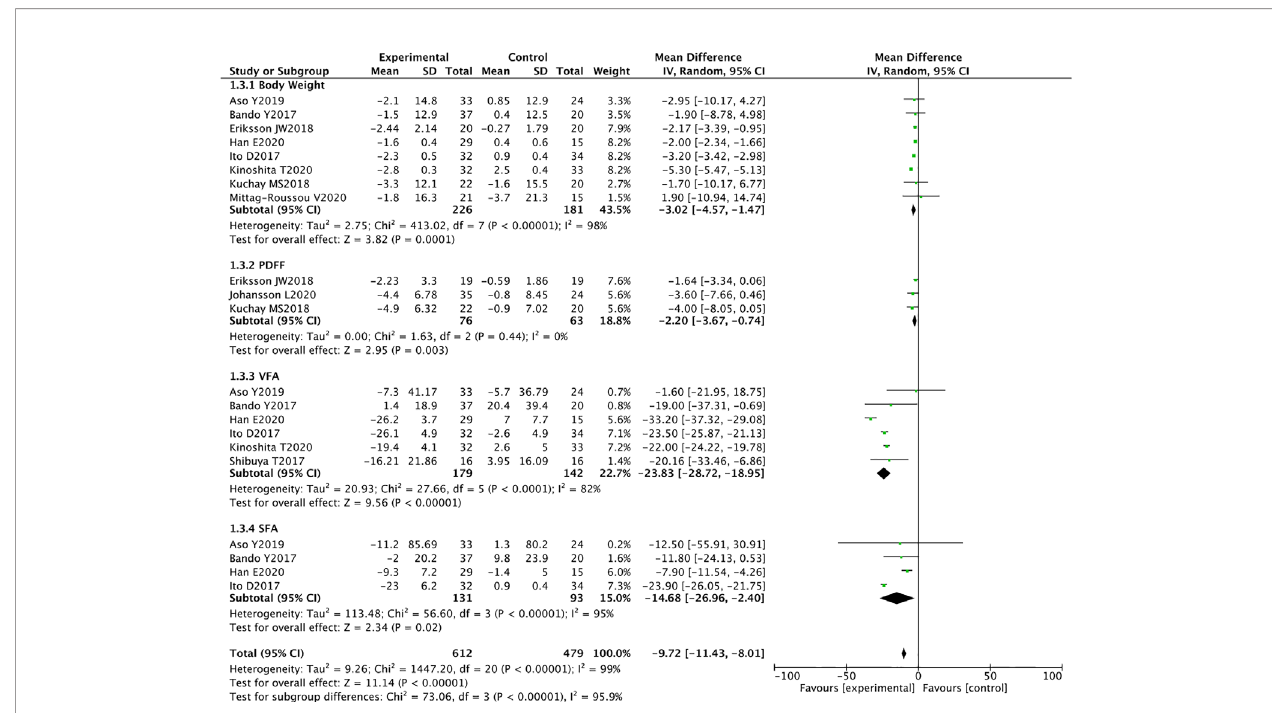
FIGURE 5 | Meta-analysis of the effect of SGLT2 inhibitors on body composition compared with the control group.